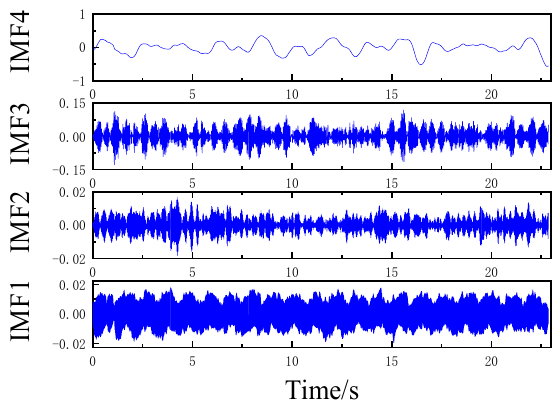
Figure 13. Time history of IMFs.